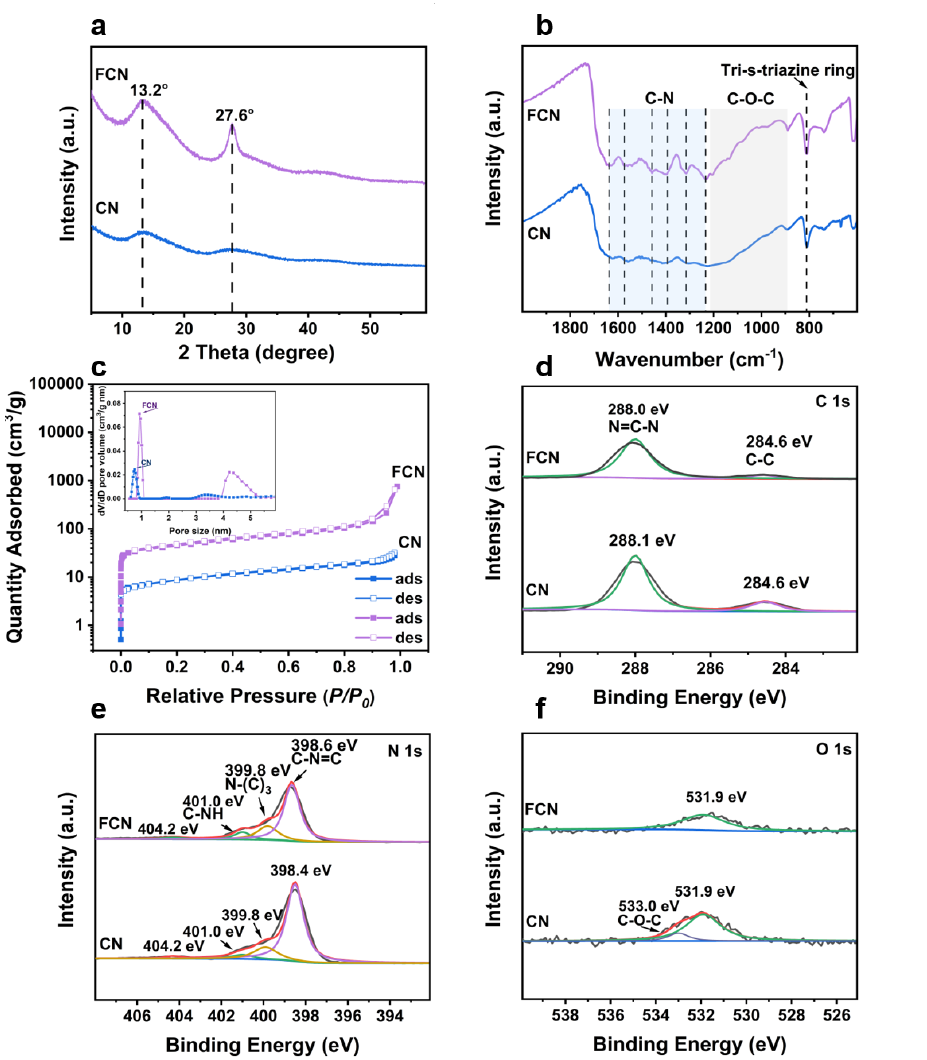
Figure 2. XRD, FT-IR, N 2 adsorption-desorption isotherms, and XPS characterizations of CN and FCN. ( a ) XRD patterns. ( b ) FT-IR spectra. ( c ) N 2 adsorption-desorption isotherms and the corresponding pore-size distribution curves (inset). ( d ) C 1s XPS spectra, ( e ) N 1s XPS spectra, and ( f ) O 1s XPS